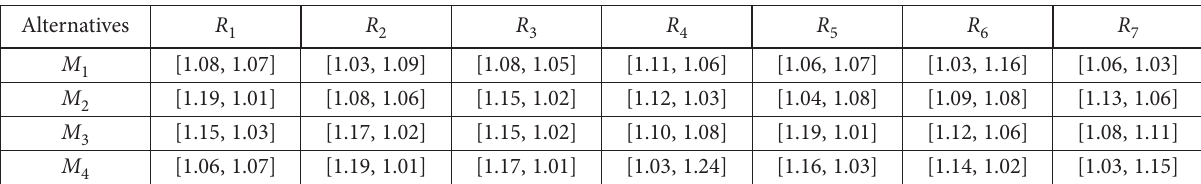
Table 8. Amount of ij Q